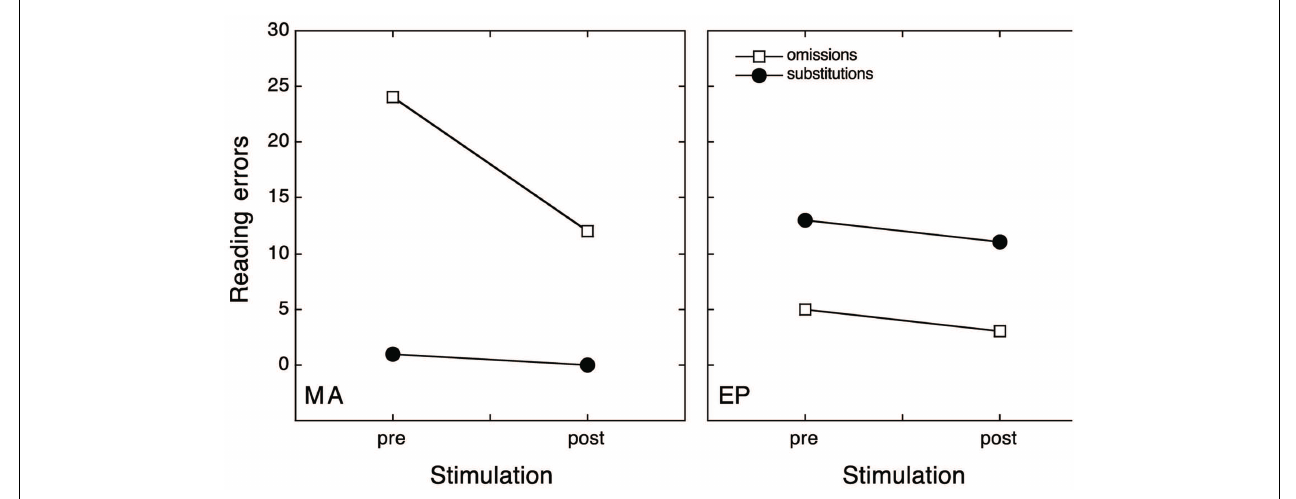
FIGURE 5 |The absolute number of letters omitted (open square) or substituted (filled dots) on the left-side of the stimulus while reading pseudowords, before and after OKS